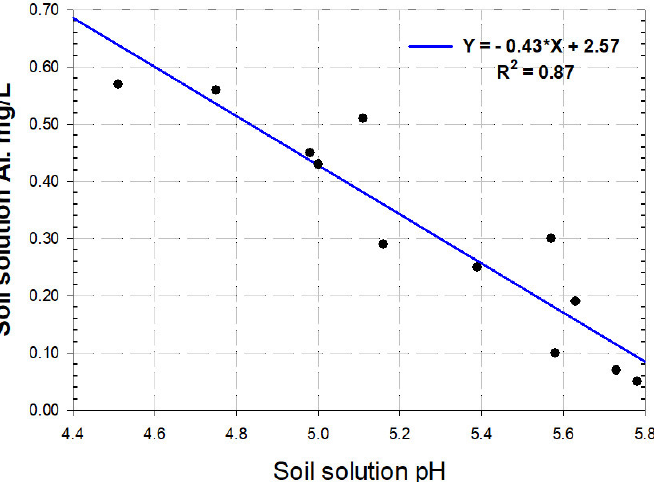
Figure 5. Soil-solution Al as a function of soil-solution pH in an acid Oxisol amended with cowpea green manure, lime, and rock phosphate.